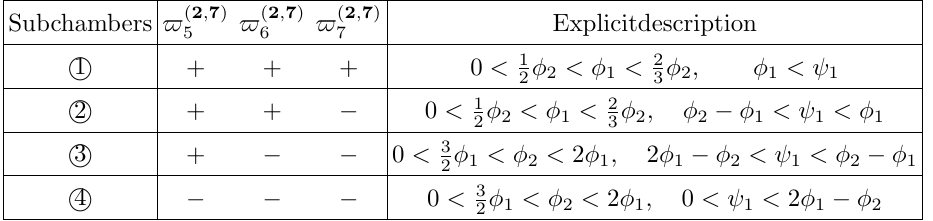
Table 3 . Chambers of the hyperplane arrangement I(A between the chamber i and i + 1 ( i = 1 ; 2 ; 3) is given by the weight $ ( 2 ; 7 )